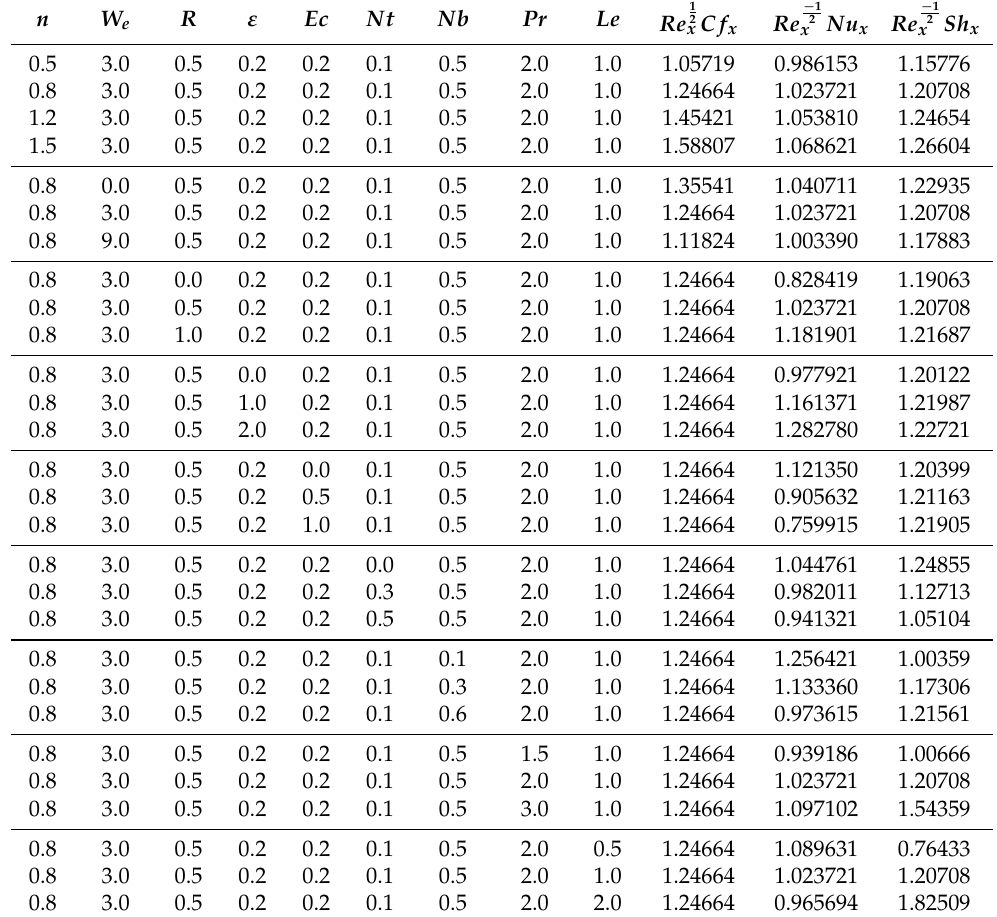
Table 2. Values of Re